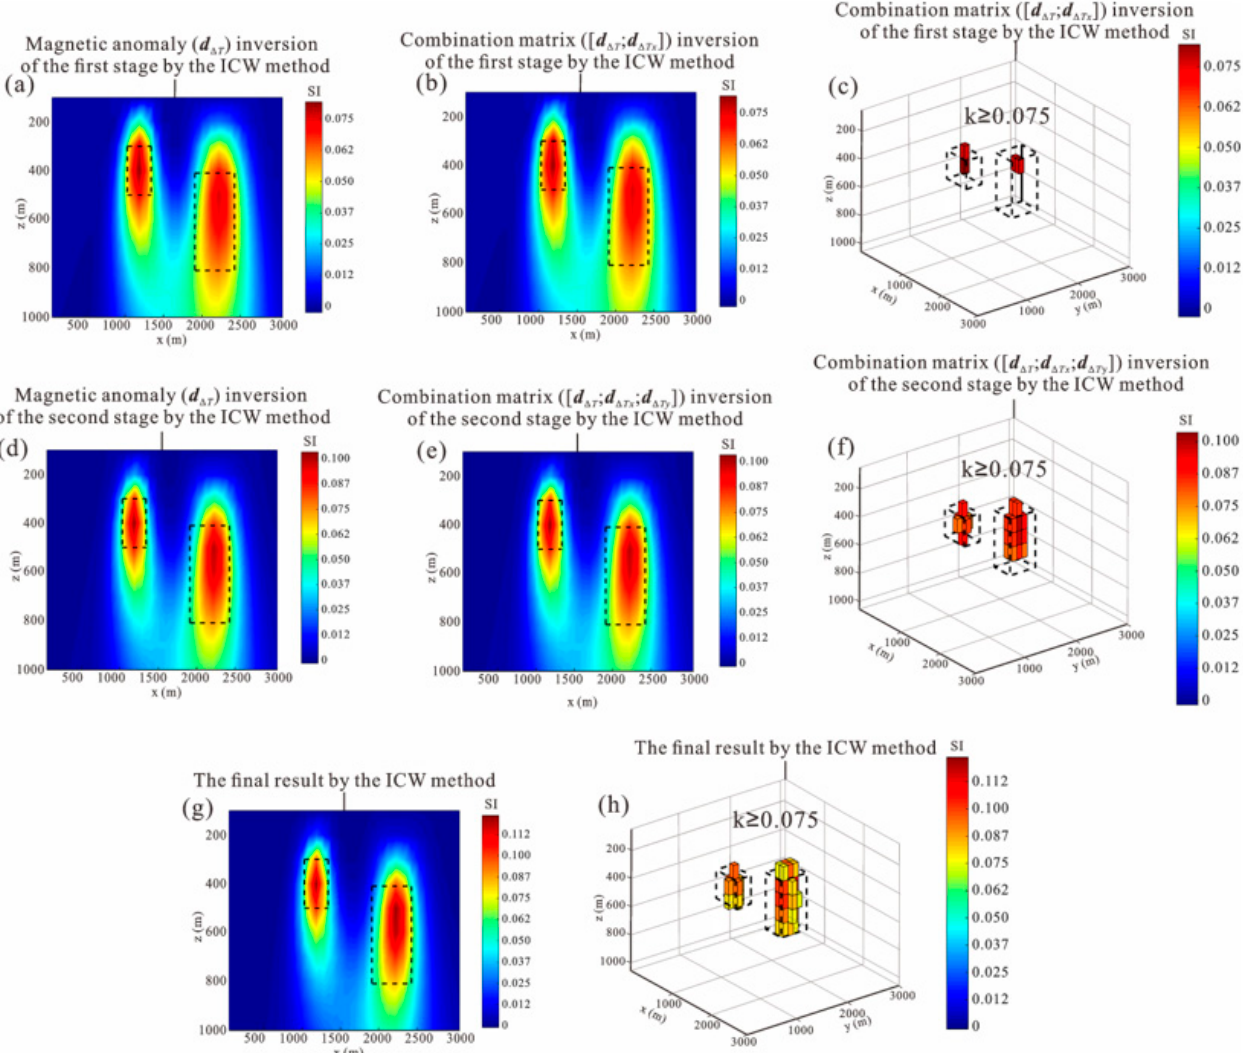
Figure 5. Magnetic susceptibility slice ( y = 1900 m) and volume-rendered images by the ICW method. ( a ) Magnetic susceptibility slice ( y = 1900 m) of the first stage of magnetic anomaly ( d ∆ T ) inversion by the ICW method. ( b ) Magnetic susceptibility slice ( y = 1900 m) of the first stage of combination matrix ] ) inversion by the ICW method. ( c ) volume-rendered image of the combination matrix ( [ d ∆ T ; d ∆ T x ] ) inversion of the first stage by the ICW method. ( d ) Magnetic susceptibility slice ( y = 1900 ( [ d ∆ T ; d ∆ T x m) of the second stage of magnetic anomaly ( d ∆ T ) inversion by the ICW method. ( e ) Magnetic suscep- tibility slice ( y = 1900 m) of the second stage of combination matrix ( [ d ∆ T ; d ∆ Tx ; d ∆ T the ICW method. ( f ) volume-rendered image of the combination matrix ( [ d ∆ T ; d ∆ Tx ; d ∆ T of the second stage by the ICW method. ( g ) Magnetic susceptibility slice ( y = 1900 m) of the